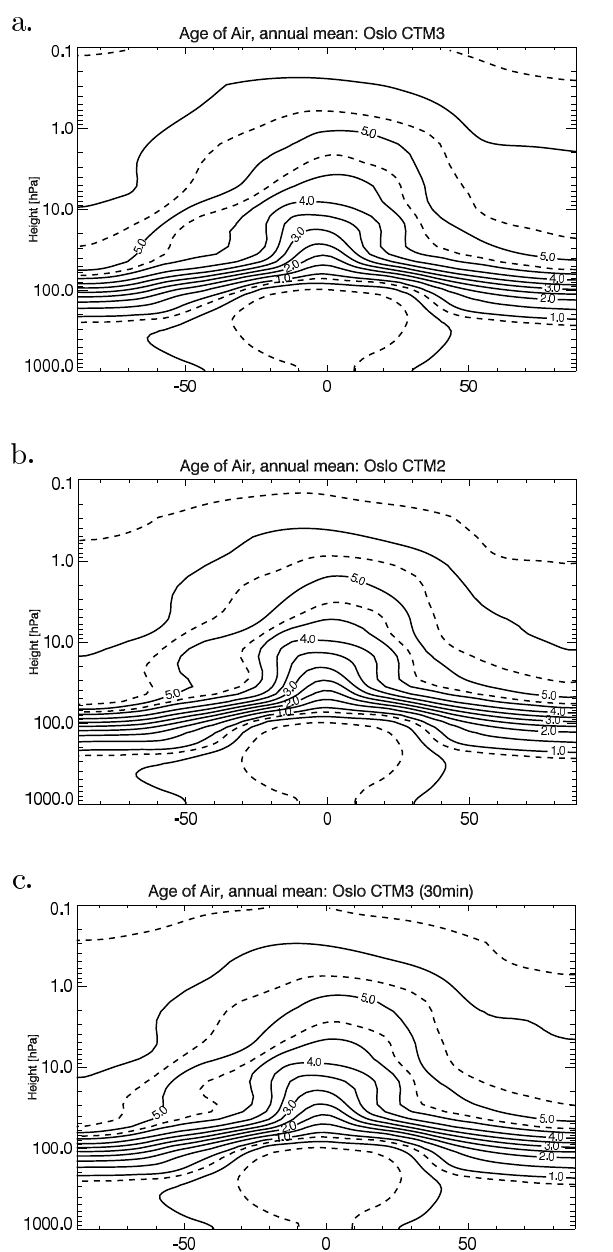
Fig. 3. Difference in annual zonal mean age of air between C3 and C2 (a) , C3 1/2 and C2 (b) and C3 1/4 and C2 (c)